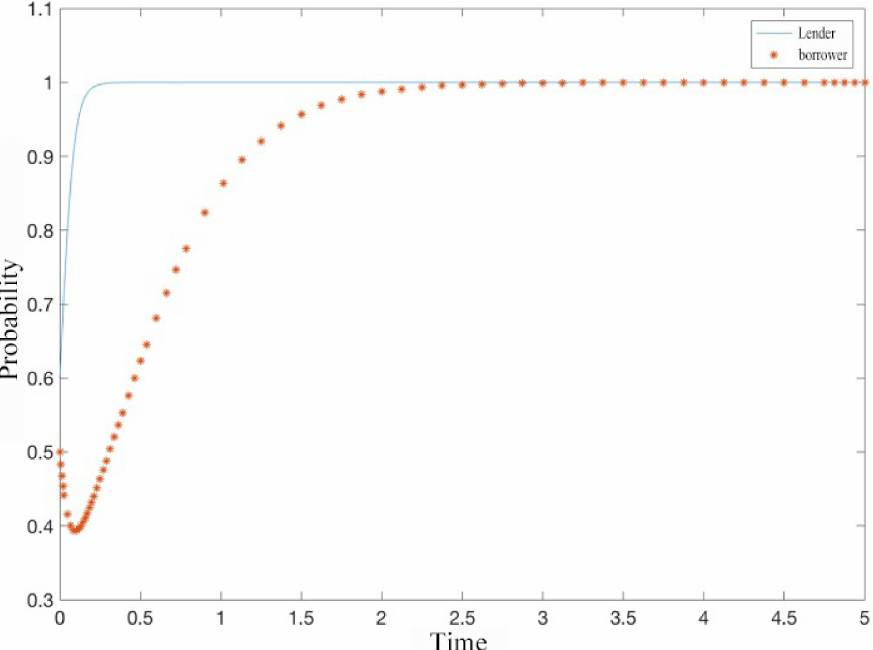
Figure 8. The dynamical evolutionary processes of the active online lending platform with proper management